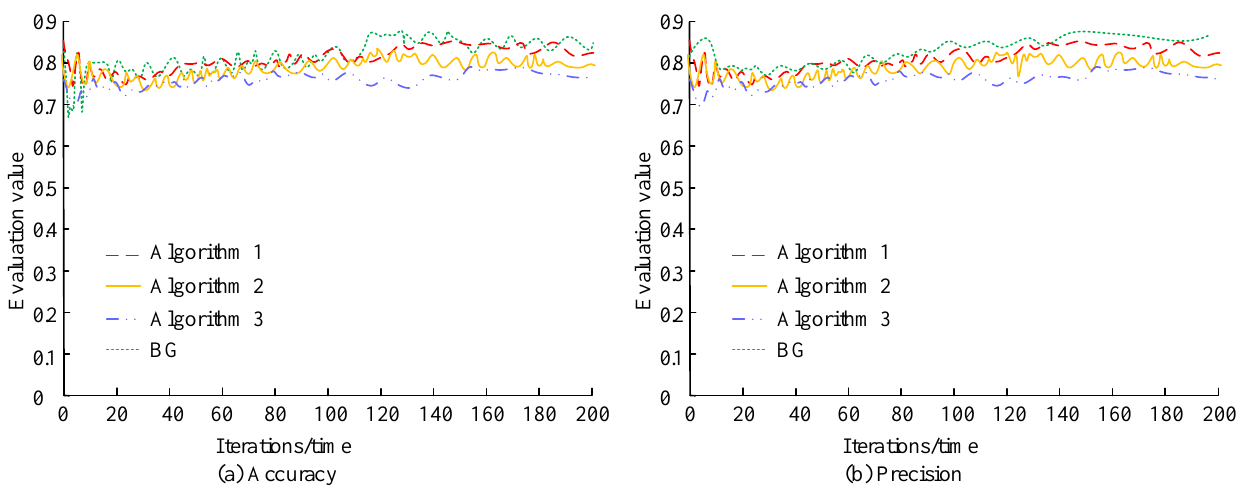
Figure 7. Accuracy and precision of four minimum cost maximum flows under different iterations. (( a ): The BG iterative algorithm has the highest accuracy, with the stable convergence values of 88.56% respectively. The accuracy range of the other three minimum cost maximum flow algo- rithms is 72.36 – 83.24%. ( b ): The BG iterative algorithm has the highest accuracy and precision. The stable convergence value is 89.12%, and the accuracy range is 73.56 – 82.15%.).